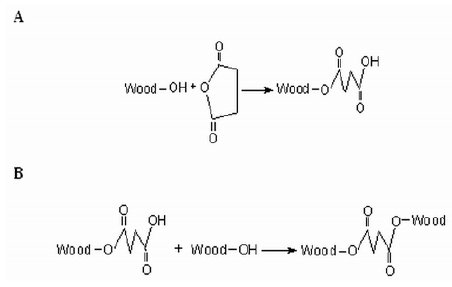
Figure 1. Chemical reaction of wood with succinic